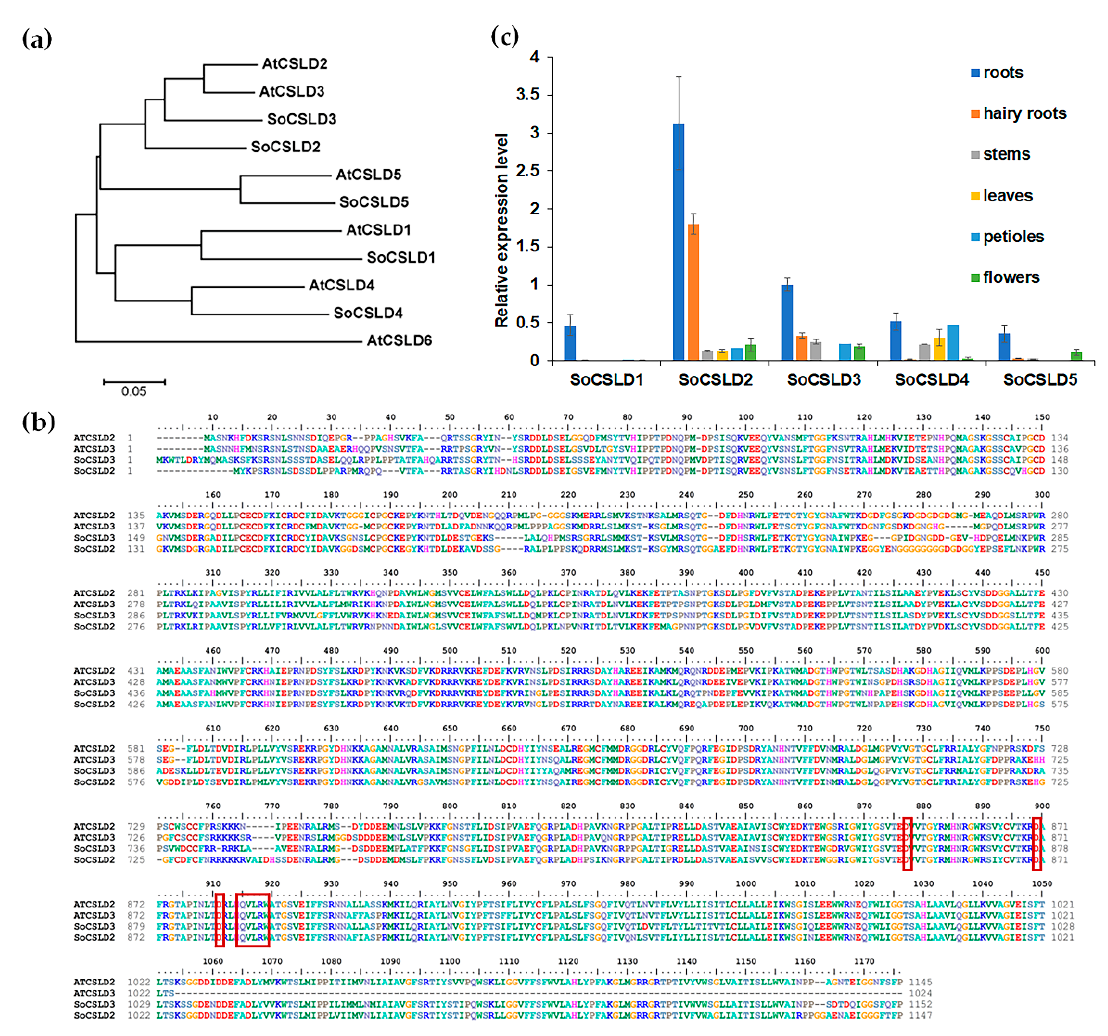
Figure 1 . Bioinformatic analysis of SoCSLD2 and SoCSLD3 and expression analysis of the five predicted CSLD genes. ( a ) Joined phylogenetic tree of CSLD members in spinach and Arabidopsis was constructed with MEGA 4.0 by the neighbor-joining (NJ) method with 1000 bootstrap replicates. ( b ) Amino acid sequence alignment of SoCSLD2, SoCSLD3, AtCSLD2, and AtCSLD3. The identical and similar amino acid residues were present with same color, respectively. The conserved motif is labeled with red frame. ( c ) The qRT-PCR detection of the expression of five genes ( SoCSLD1 , SoCSLD2 , SoCSLD3 , SoCSLD4 , and SoCSLD5 ) in the stem, leaf, flower, stipe, root, and hairy root of spinach. The relative mRNA abundance of each gene in all samples was normalized with respect to reference gene Spo23599 , an actin gene of spinach.